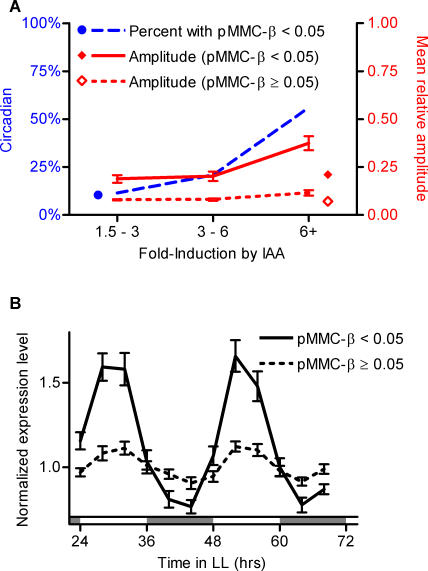
Correlation between Auxin-Responsiveness and Circadian Regulation(A) Relationship between degree of induction by auxin [36] and circadian regulation is presented. Genes were classified on the basis of responsiveness to auxin (x-axis), and the percent with clock-regulated gene expression (pMMC-β < 0.05) was plotted in blue on left y-axis; we found a significant correlation between fold induction and percent rhythmicity (χ2 test: p = 2.3 × 10−06). A closed blue circle (left) represents the percent of all expressed nuclear-encoded genes that are circadian regulated. There is a strong correlation between fold induction by IAA and relative amplitude of circadian-regulated genes (pMMC-β < 0.05) and a weak correlation for noncircadian genes (1 > pMMC-β ≥ 0.05), plotted in red on the right y-axis (circadian/IAA: r
s = 0.680, p = 4.1 × 10−07; noncircadian/IAA: r
s = 0.182, p = 1.4 × 10−02). Indeed, there are significant differences in relative amplitude of circadian genes between highly IAA-induced and other IAA-induced genes (t-tests: (6+) versus (3 − 6), p = 7.9 × 10−04; (6+) versus (1.5 − 3), p = 2.2 × 10−04). Discrete data points on the right represent the mean relative amplitude of all expressed nuclear-encoded genes that are circadian regulated (closed red diamond) and noncircadian (open red diamond).(B) Mean normalized microarray expression data for highly auxin-induced genes are presented [36]. Genes induced by auxin >6-fold have been classified as circadian regulated (pMMC-β < 0.05 and 19 ≤ period ≤ 29 h) or not (pMMC-β > 0.05 and/or period ≤ 19 or ≥ 29 h). Error bars represent the standard error of the mean.